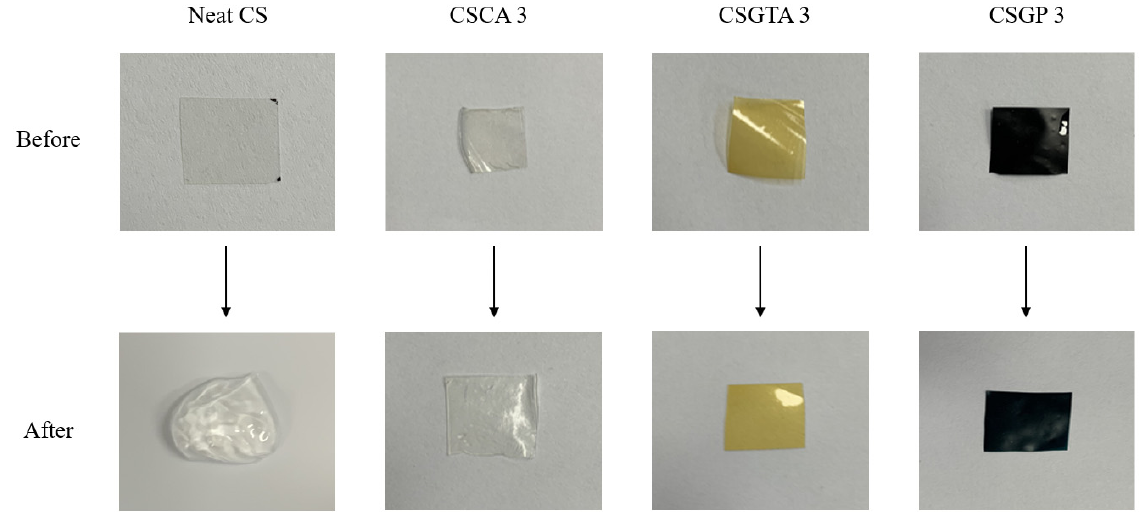
Figure 3. Morphology changes of the crosslinked CS films before and after the swelling test in PBS (pH 7.4) for 24 h.